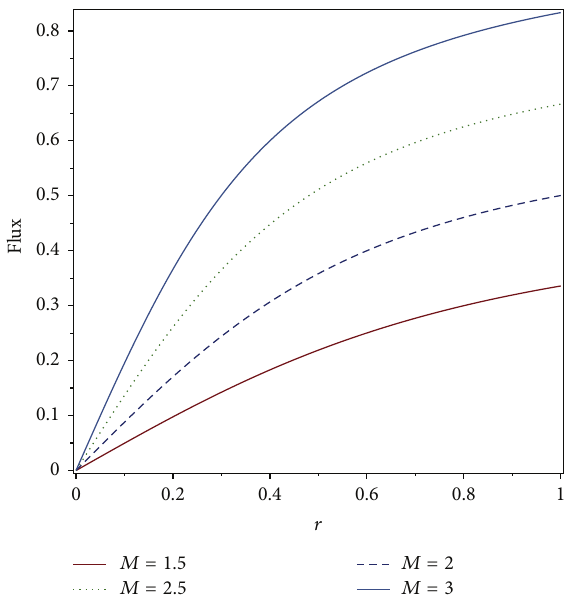
Figure 10: Heat flux for varying values of 𝑀 .